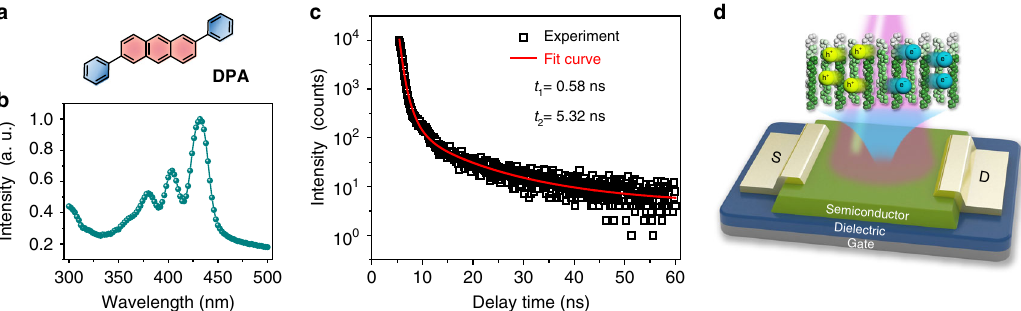
Fig. 1 Device structure and optical feature of DPA fi lm. a Molecular structure of DPA. b UV – vis absorption spectra of DPA fi lm. c Spectral-dependent photoluminescence (PL) decay of DPA fi lm. d Schematic diagram of